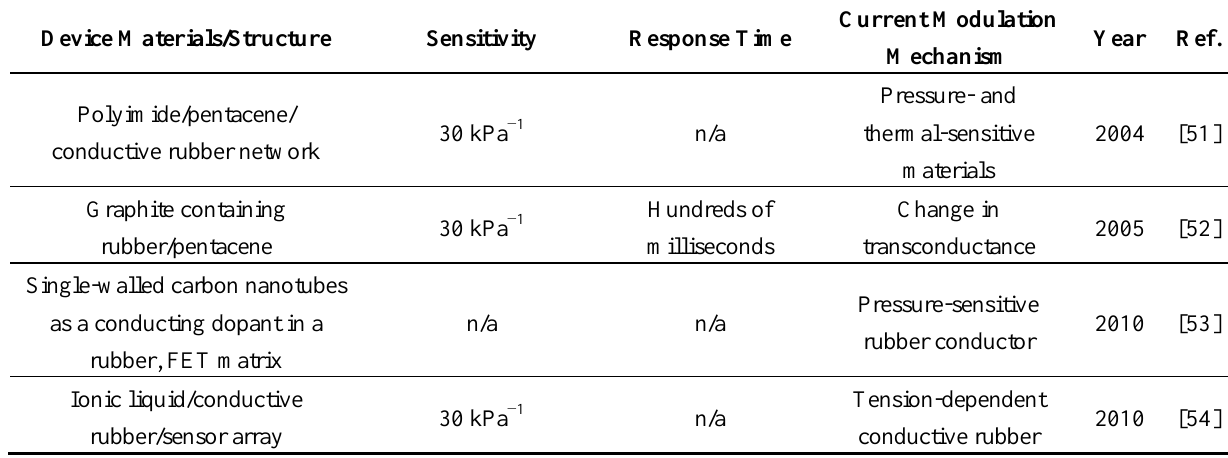
Table 2. A summary of the pressure-sensing devices discussed in this